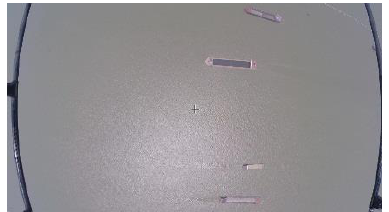
Figure 5. The Original Image.